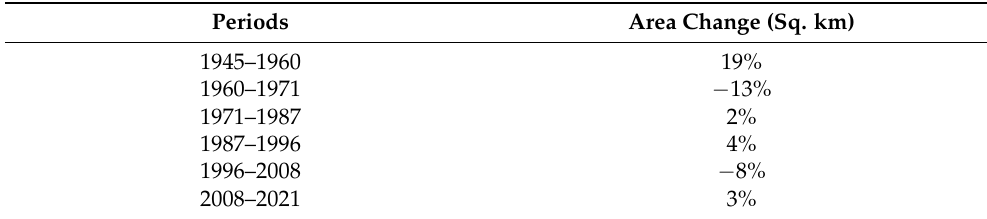
Table 7. (%) Multitemporal rates of changes in the extension of the Prokopos Lagoon.